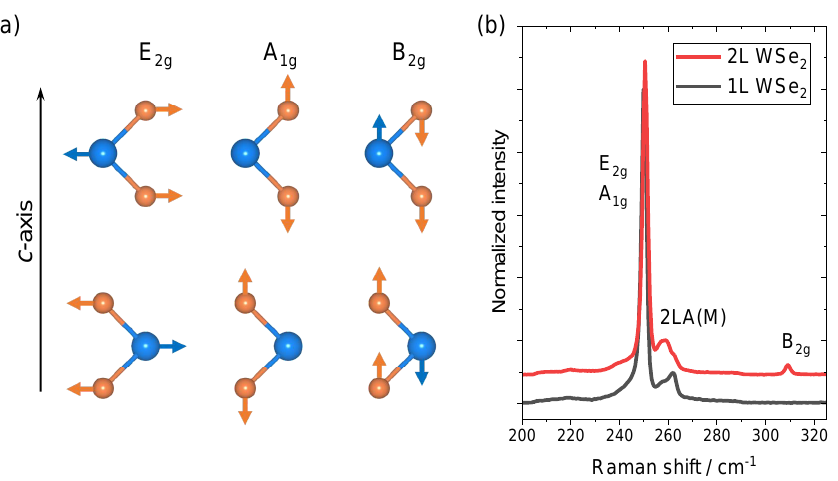
Figure 1. ( a ) E 2 g , A 1 g , and B 2 g vibrational modes of 2H-phase bilayer WSe 2 . ( b ) Raman spectra of monolayer and intrinsic bilayer WSe 2